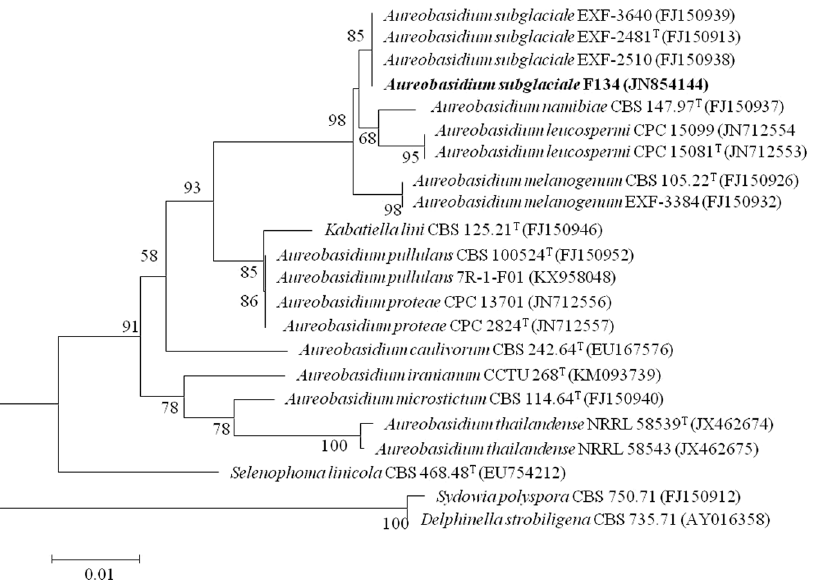
Figure 1. Phylogenetic tree, reconstructed based on the D1/D2 domain of LSU rRNA gene by using the neighbor-joining method implemented with MEGA version 7.0, showing that the strain A. subglaciale F134 had a great similarity with relevant species in the geuns Aureobasidium . Bootstrap values > 50% were shown on the branches and bootstrap values were set at 1000 iterations. The scale bar was considered as an evolutionary distance of 0.01 nucleotide substitution